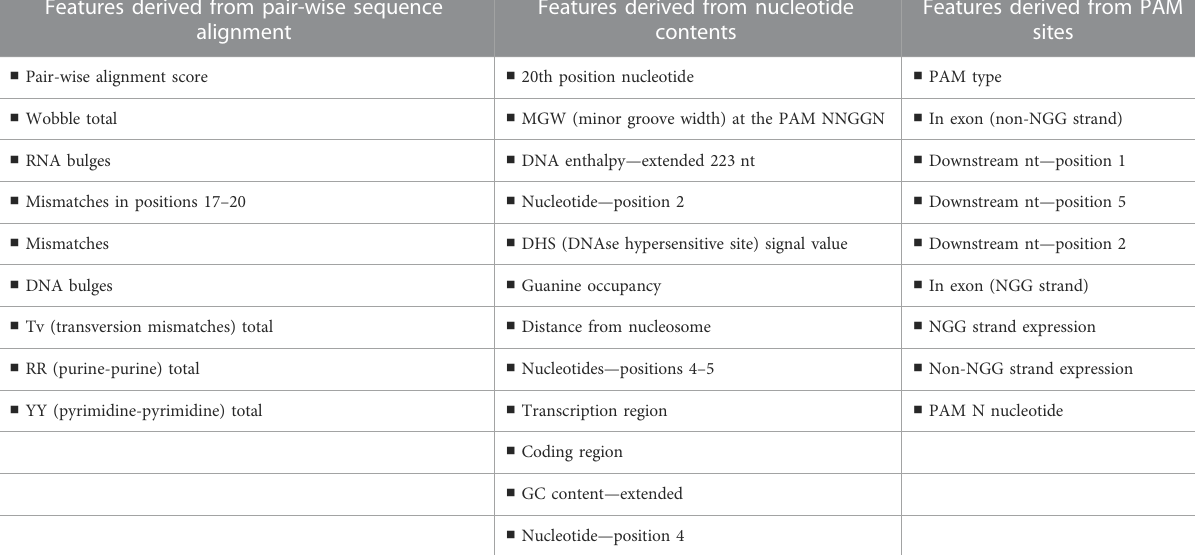
Features derived from nucleotide contents